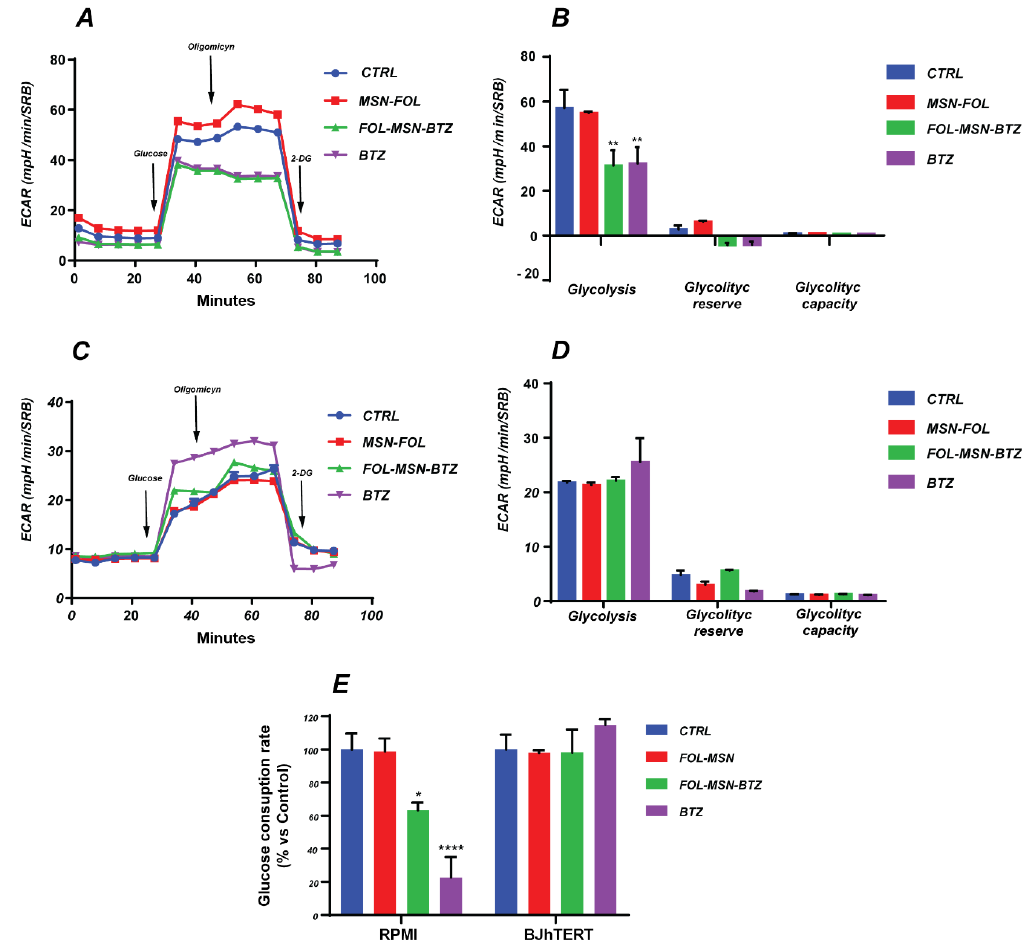
Figure 3. Glycolytic signature induced by BTZ-loaded MSNs in RPMI-8226 and BJhTERT cell lines compared to free BTZ. The glycolytic profile of cancer and normal cells treated for 1 h with FOL-MSN-BTZ, MSN-FOL and BTZ (as positive control) or left untreated (Control), was assessed 18 h after MSNs treatment using the Seahorse XF-e96 analyzer. The modulators glucose (30 min), Oligomycin (50 min) and 2-DG (70 min) were serially injected for ECAR measurement. A schematic tracing of ECAR flux in RPMI-8226 ( A ) and BJhTERT ( C ) and a graphic representation of Glycolysis, Glycolytic reserve and Glycolytic capacity in RPMI-8226 ( B ) and BJhTERT ( D ) are reported. ( E ) Glucose consumption was assessed in cancer and normal cells as described in the Section 3. Data represent the mean ± SEM of three independent experiments performed in sextuplicate and normalized by protein content (SRB). (*) p < 0.05; (**) p < 0.01; (****) p < 0.0001.